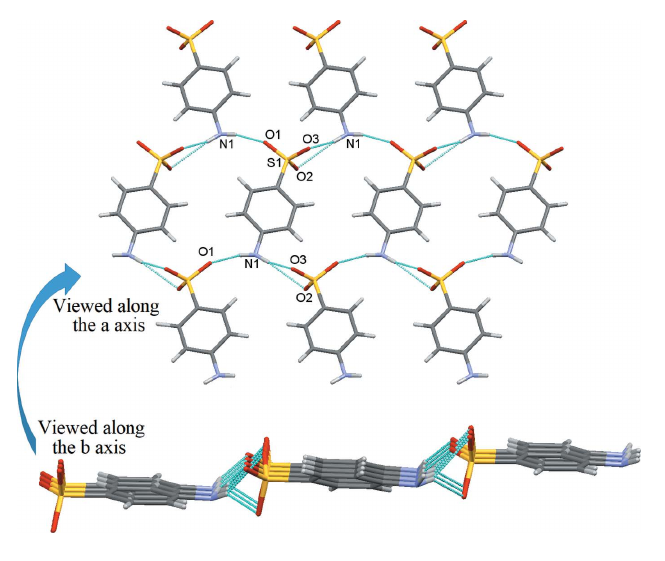
Figure 2 A perspective view of an infinite layer, viewed along the a and b axes.